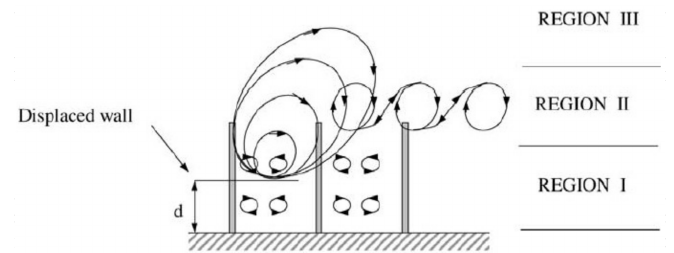
Figure 1. Regions of the canopy sub-layer